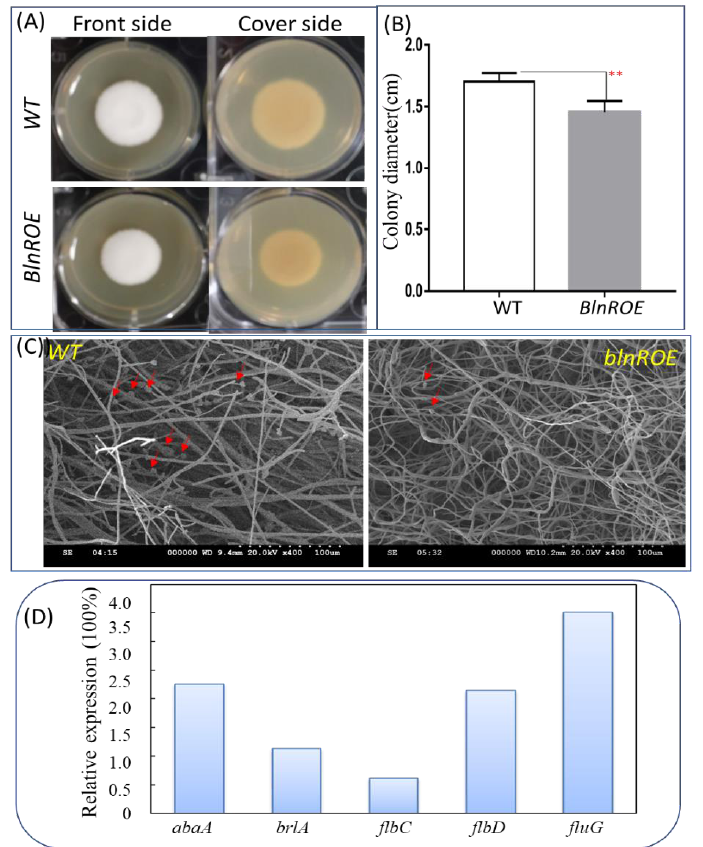
Figure 5. Effects of BlnR on the development of asexual conidiospore and filamentous growth. ( A ) A total of 10 3 spores were spotted on a PDA plate for growth at 26 °C for 7 days. ( B ) Comparison of colony size between the wild-type and blnR OVE (n = 10) strains. “**” indicates the significant dif- ference with the p -value 0.01. ( C ) Microscopic observation of hyphae and spores. The red arrows indicate spores. ( D ) qRT-PCR analysis of spore-development-related regulators (n = 3). We further investigated the differential expression pattern between blnR OE and the